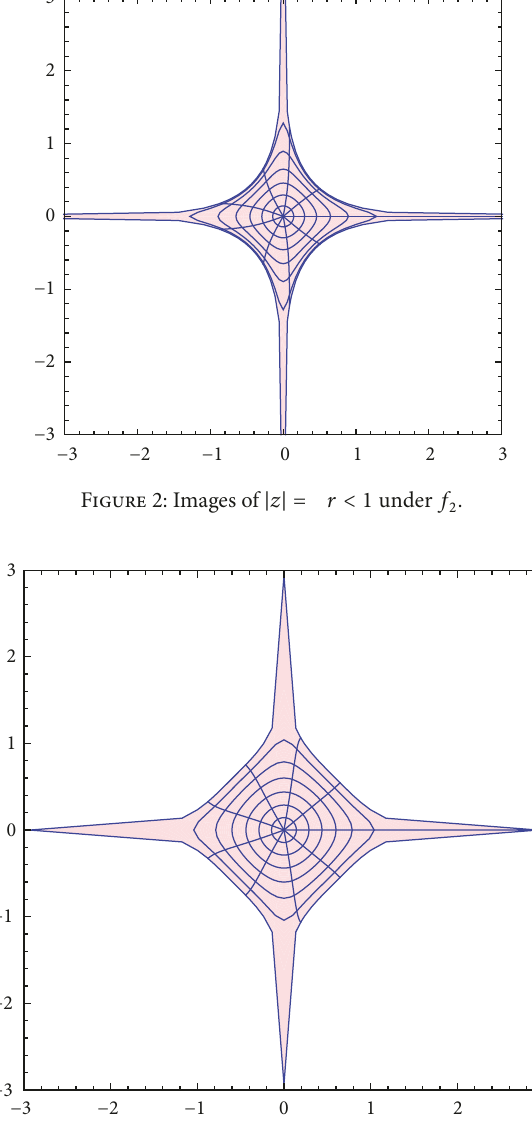
Figure 3: Images of |𝑧| = 𝑟 < 1 under 𝑓 1 ∗ 𝑓 2